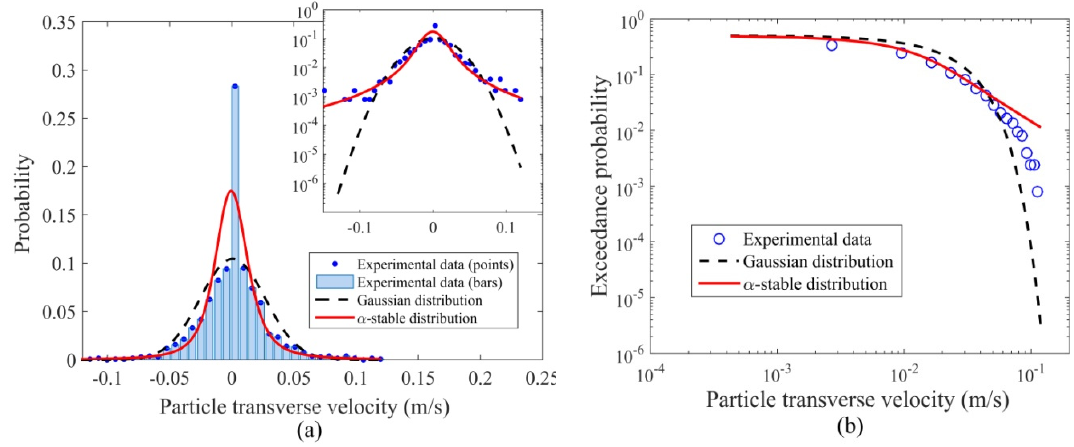
Figure 5. ( a ) Discrete probability distribution of the transverse particle velocity ( ∆ t = 0.1 s) with theoretical lines that fit the data; the inset shows the same data on a semilog plot. ( b ) Exceedance probability of the particle transverse velocity.